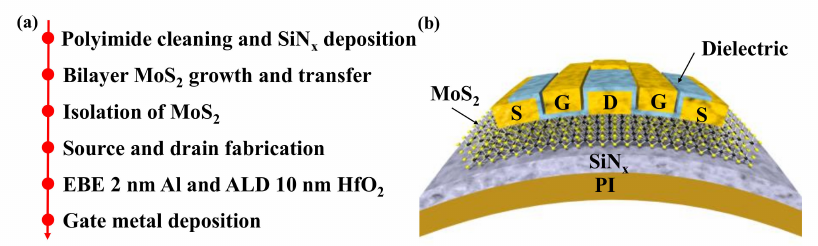
Figure 2. ( a ) Process flows and ( b ) schematic cross-section of the fabricated flexible bilayer MoS 2 RF transistors.